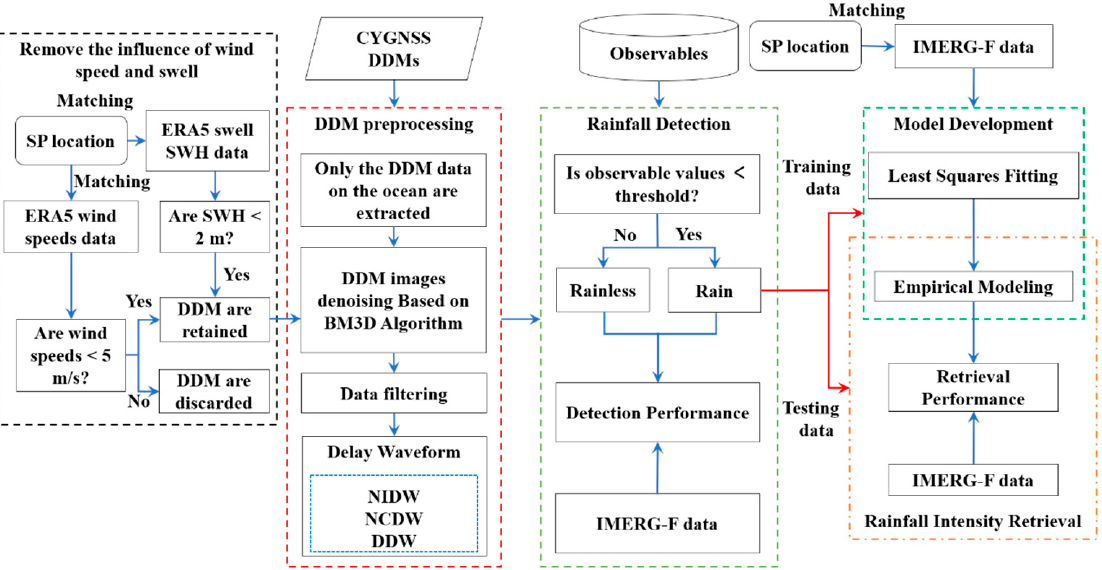
Figure 3. Flow chart of RD and RI retrieval. It is divided into six steps: Step 1 removes the influence of wind speed and swell; Step 2 performs data preprocessing; Step 3 calculates GNSS-R observables; Step 4 carries out data matching; Step 5 performs RD and detection performance evaluation; and Step 6 develops the RI retrieval model (marked in the green box) and verifies model performance (marked in the orange box).